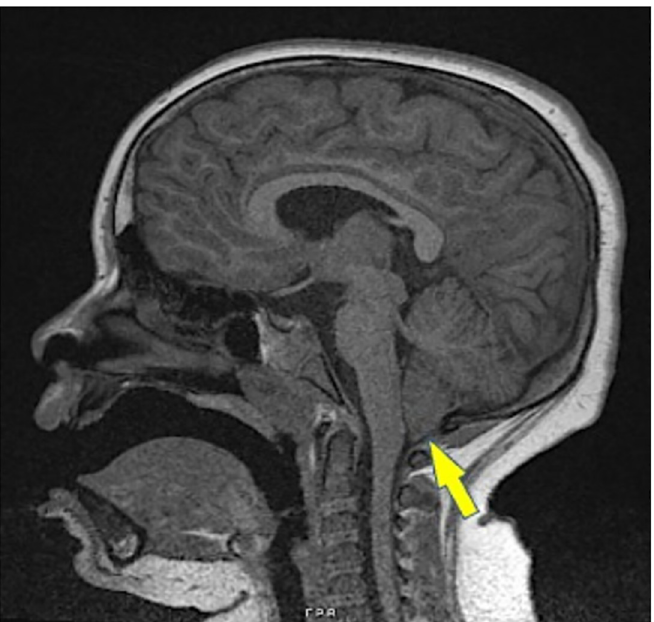
Fig 2. Brain MRI of PHP1A participant. Sagittal MRI image from participant #5. The cerebellar tonsils extend 7 mm below the foramen magnum reflecting Chiari type 1 malformation.